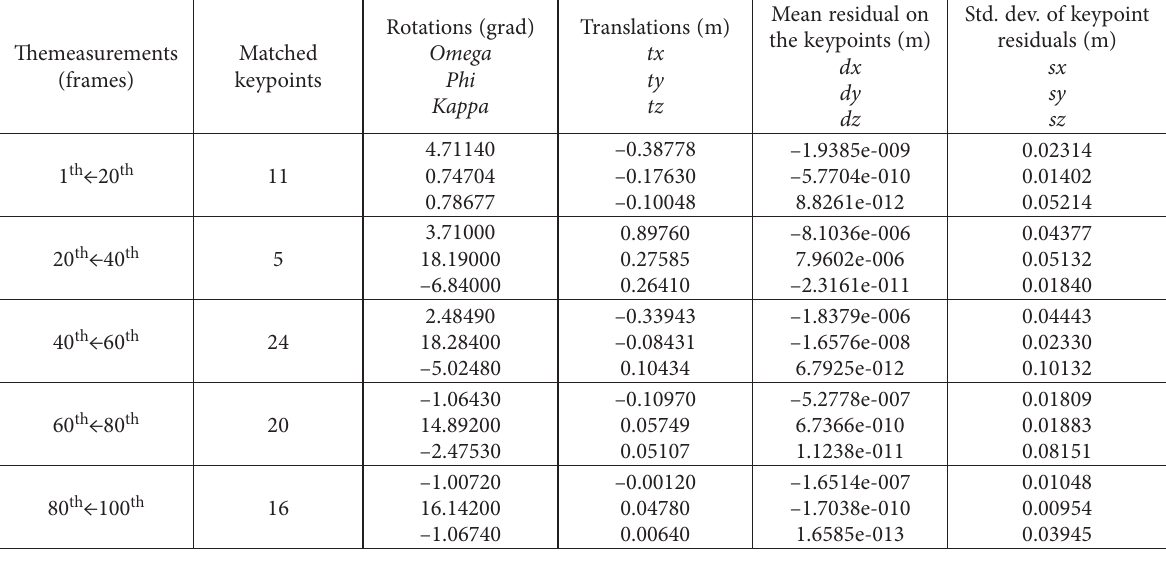
Themeasurements